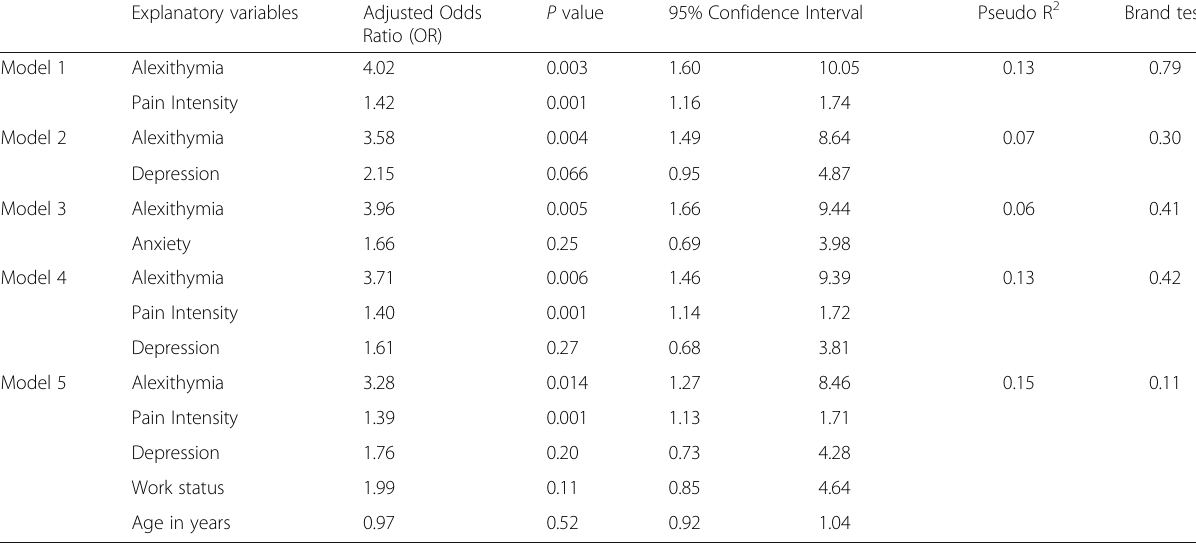
Table 3 Adjusted Odds Ratio of predictors of disability degree in Fibromyalgia women P value 95% Confidence Interval Pseudo R 2 Brand test Explanatory variables Adjusted Odds Ratio (OR) Model 1